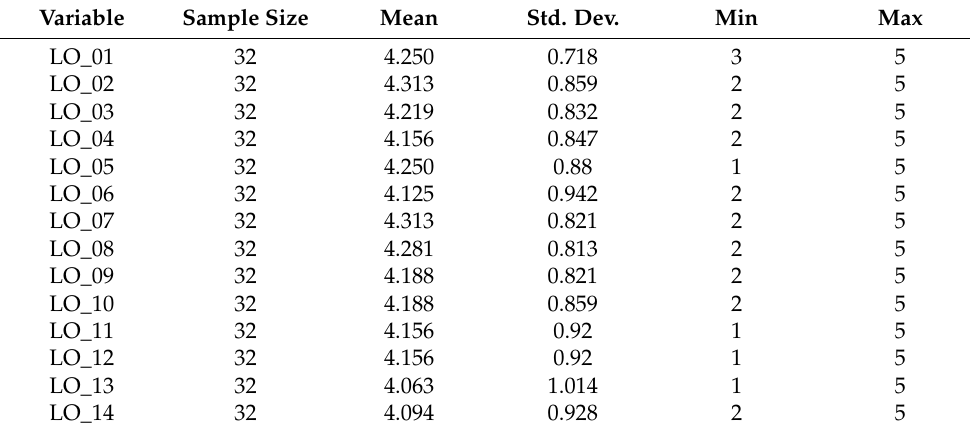
Table 11. Descriptive statistics by learning outcomes’ items.